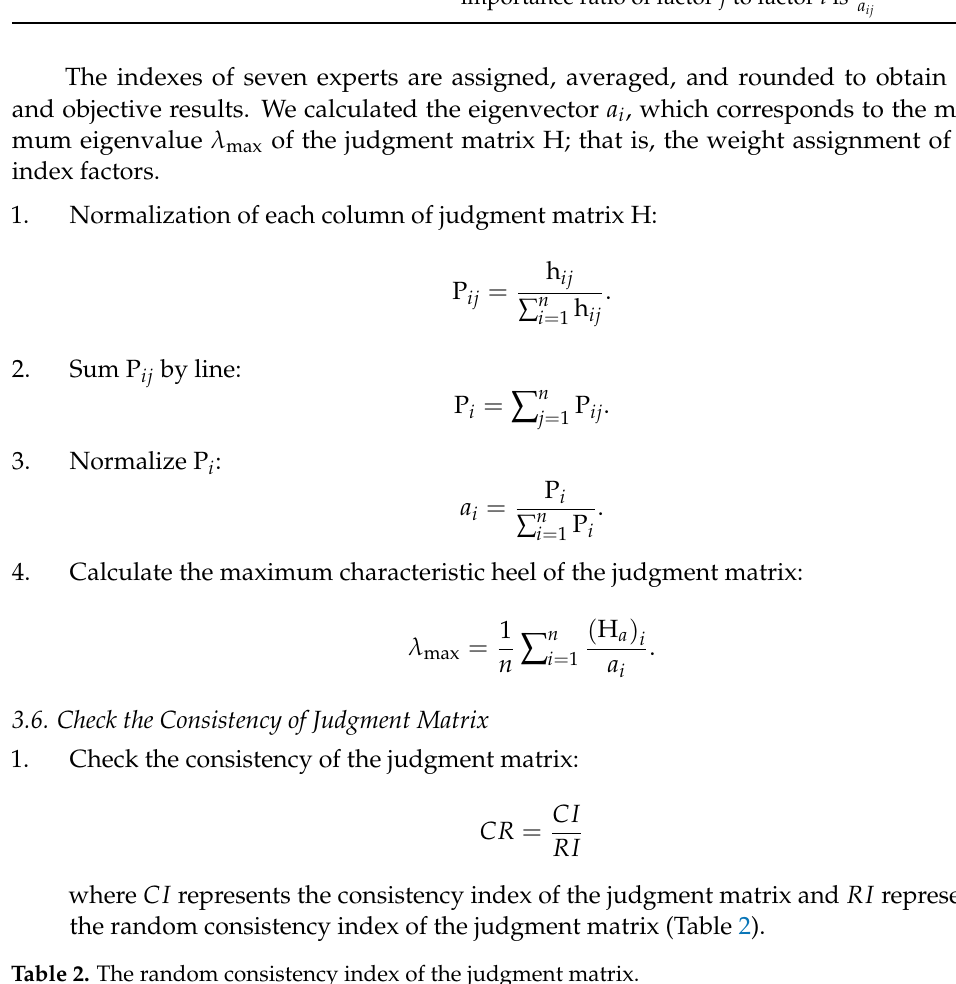
Table 1. 1–9 proportional scaling method. Scale Meaning (Element i Is the Vertical Factor in the Table, a ij Scale Element j Is the Horizontal Axis Factor in the Table) 1 i has the same importance as j Compared with the two factors of i and j , the horizontal is 3 slightly more important than the vertical Compared with the two factors of i and j , the horizontal is more 5 important than the vertical Compared with the two factors of i and j , the horizontal is 7 much more important than the vertical Compared with the two factors of i and j , the horizontal is 9 absolutely more important than the vertical 2, 4, 6, 8 Intermediate value of i and j judgment Reciprocal